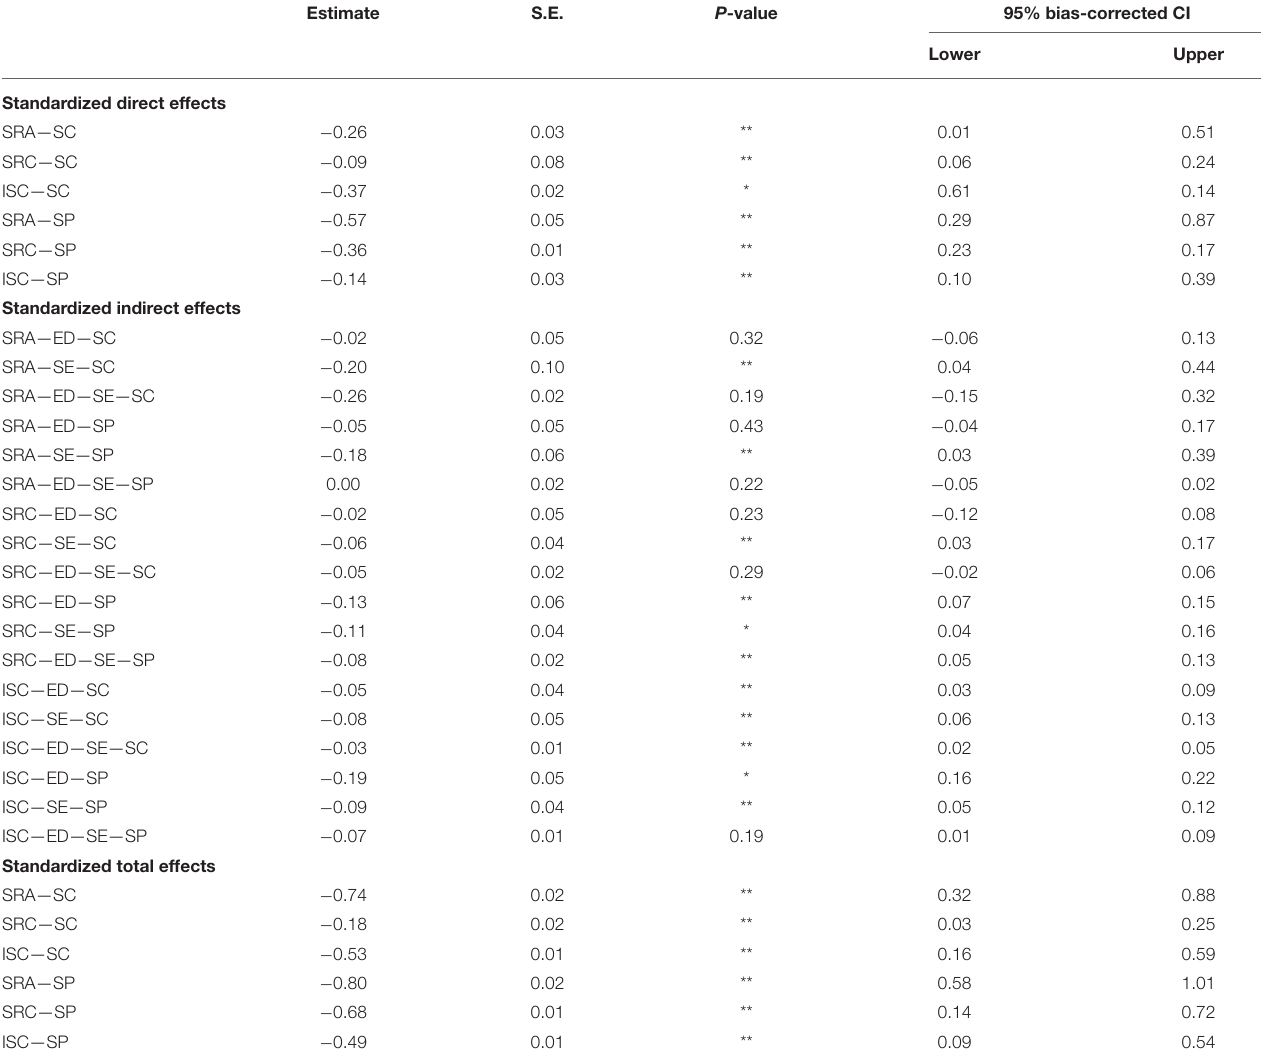
TABLE 4 | Standardized direct effects, indirect effects, and total effects of the conceptual